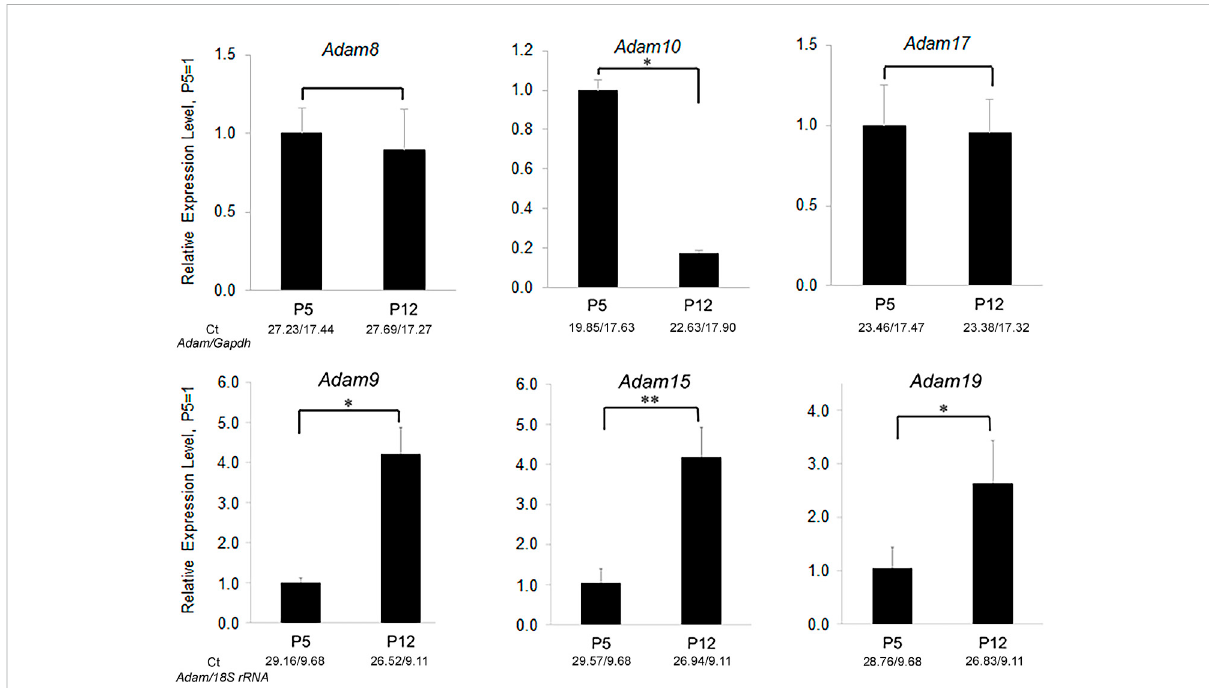
FIGURE 2 Relative expression levels of ADAM family members in murine fi rst molar enamel organs from P5 (secretory stage) and P12 (maturation stage) mice. qPCR demonstrated that Adam8, 9, 10, 15, 17 , and 19 were expressed in mouse enamel organs (Ikeda et al., 2019). However, only Adam10 was expressed predominantly in the secretory stage when ameloblast movement occurs. Three biological replicates were analyzed for each of three experiments (*, p < 0.05; **, p < 0.01; Ct, cycle